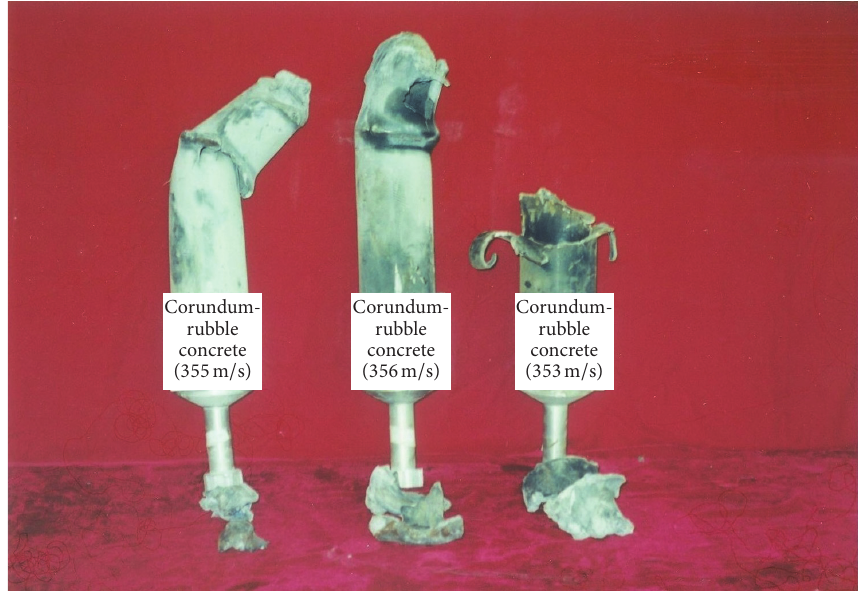
Figure 7: Damaged projectiles of CRC